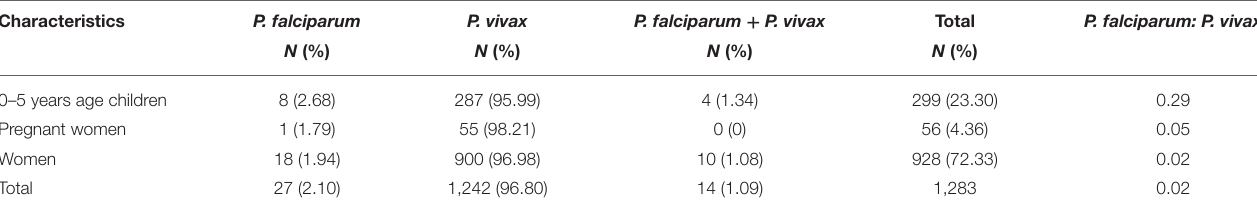
TABLE 3 | Prevalence of malaria infection by age and sex.